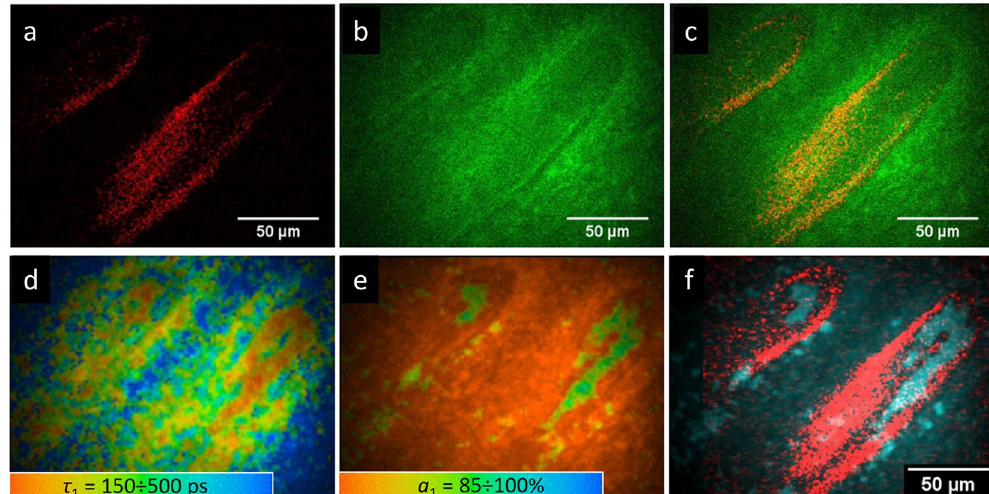
Figure 2. Two-photon imaging of the fingernail bed area: ( a ) SHG signal, ( b ) TPEAF signal, ( c ) merged SHG and TPEAF signals, ( d ) FLIM image, colors correspond to the τ 1 values (the color scale corresponds to the 150– 500 ps range), ( e ) FLIM image, colors correspond to the a 1 values (the color scale corresponds to the 85–100% range), ( f ) merged SHG and FLIM